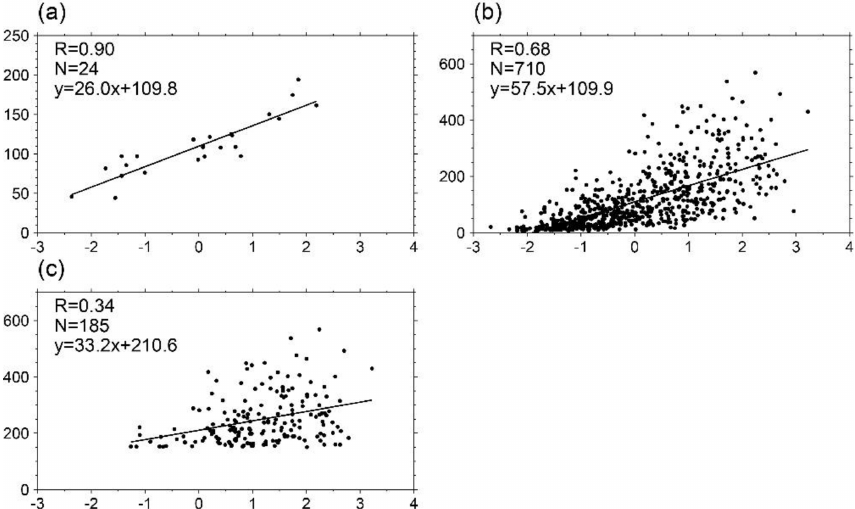
Figure 4. Correlations between PC1 (defined by V850 and RH in SHEN; horizontal axis) with observed wintertime PM 2 . 5 concentrations in Beijing (µgm − 3 ; vertical axis) for (a) monthly PM 2 . 5 concentrations and PC1, (b) daily PM 2 . 5 concentrations and PC1, and (c) daily PM 2 . 5 concentrations and PC1 for severe haze days (daily mean PM 2 . 5 ≥ 150µgm − 3 ). In each panel, N is the number of samples in the studied time period of 2010–2017 as in SHEN, and R is the correlation